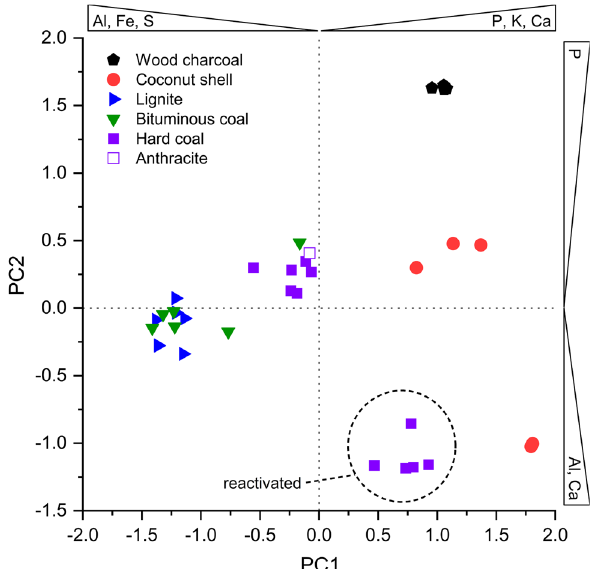
Fig. 3 Score plot of the principal component analysis (PCA) with points representing 34 ACs (GACs and PACs) and anthracite, ana- lyzed by X-ray fluorescence spectroscopy (XRF). Elements contribut- ing the most to principal components (PC) 1 and 2 are indicated at the top and on the right-hand side, specific contributions (loadings) are provided in SI (Fig.